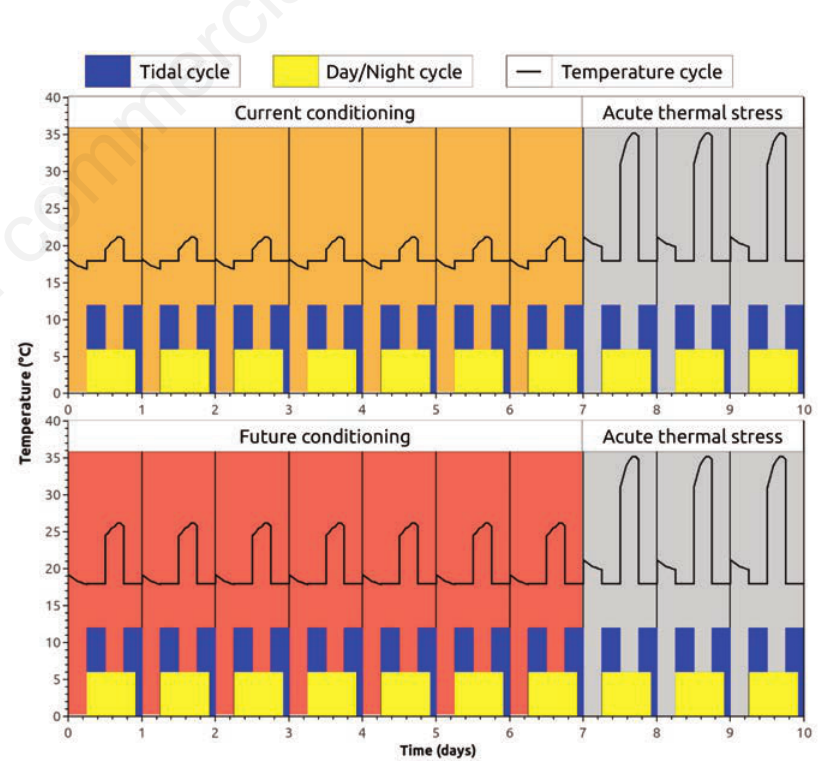
Figure 1. Tidal, day/night and temperature cycles setting in microcosm exposition. Mussels were exposed in parallel for 7 days to present temperature (current conditioning) or to higher temperature (future conditioning). Then, both groups were exposed to an identical acute thermal stress for 3